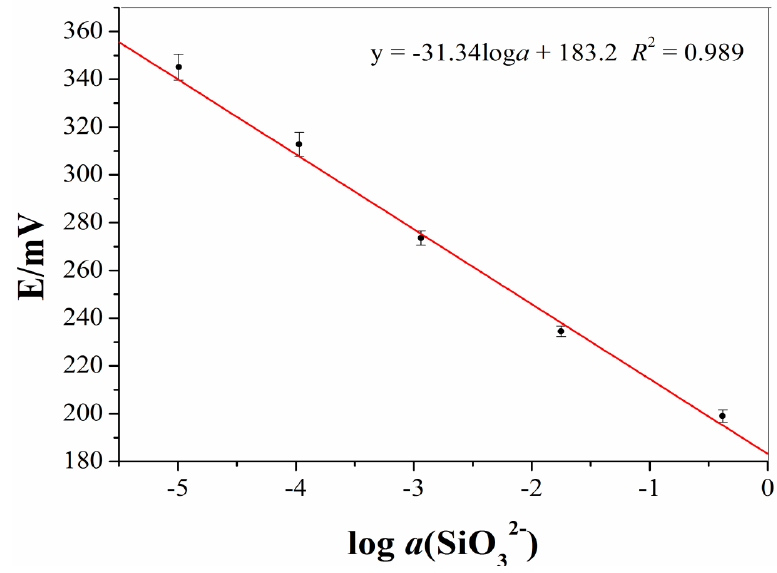
Figure 2. The calibration curves of the seven all-solid-state silicate ISEs that were prepared using the same method.